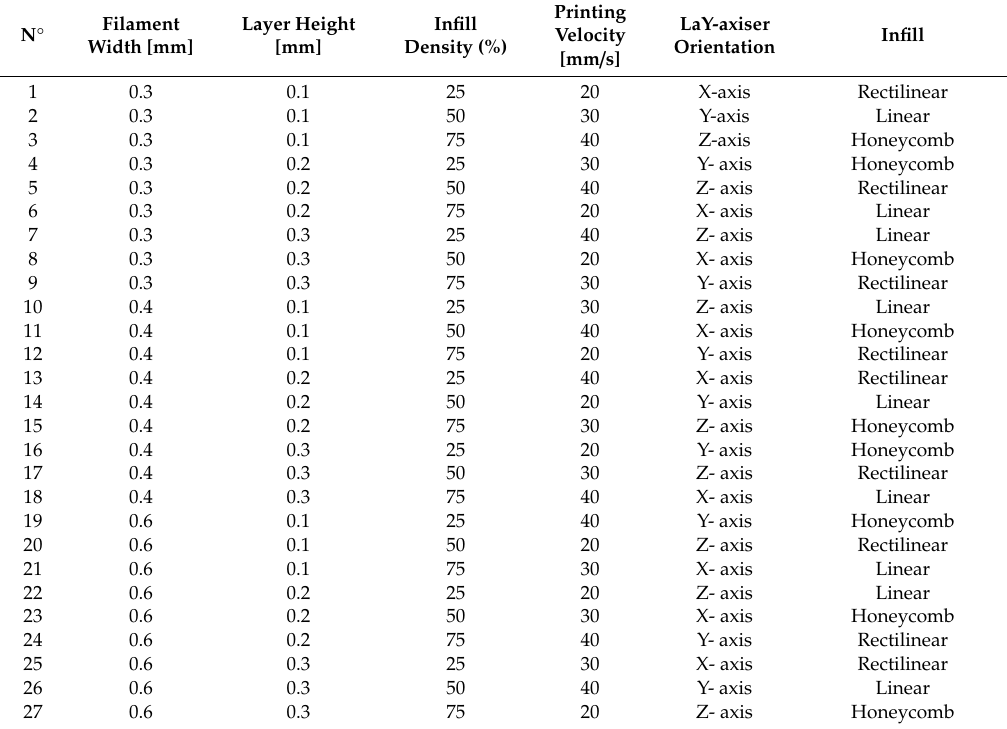
Table 3. Orthogonal matrix of Taguchi L27 for the DOE.